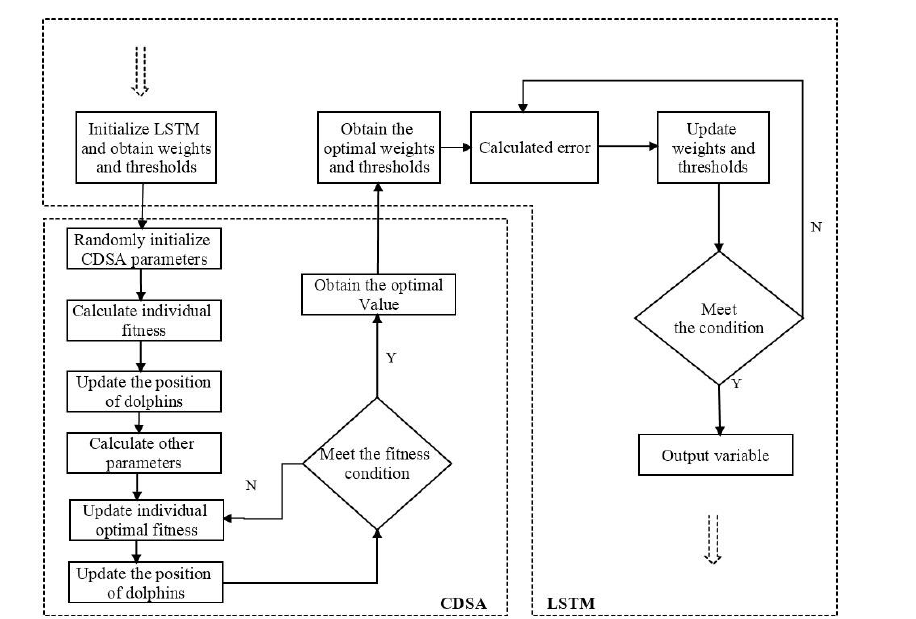
Fig. 5. The CDSA-LSTM algorithm